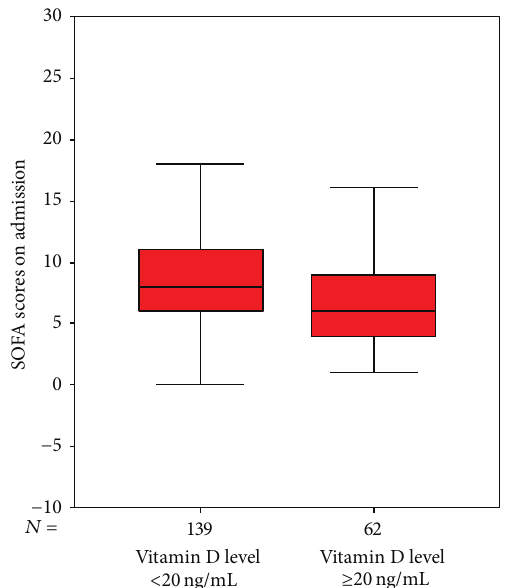
Figure 6: Albumin levels of vitamin D sufficient and insufficient groups (𝑃 = 0.01) .